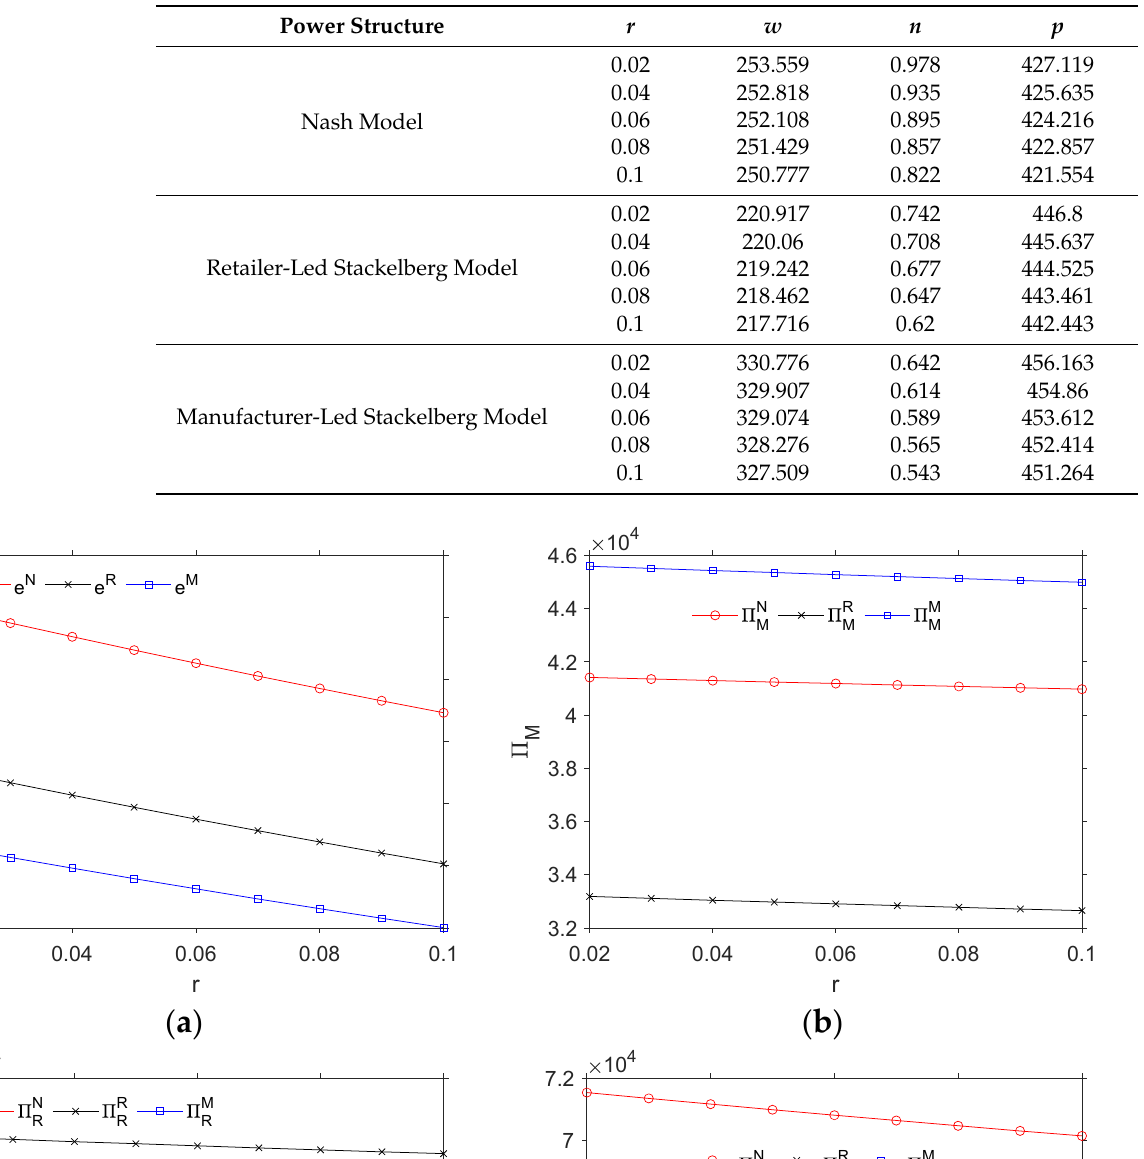
Table 4. The sensitivity of the optimal decisions of the supply chain with respect to r .